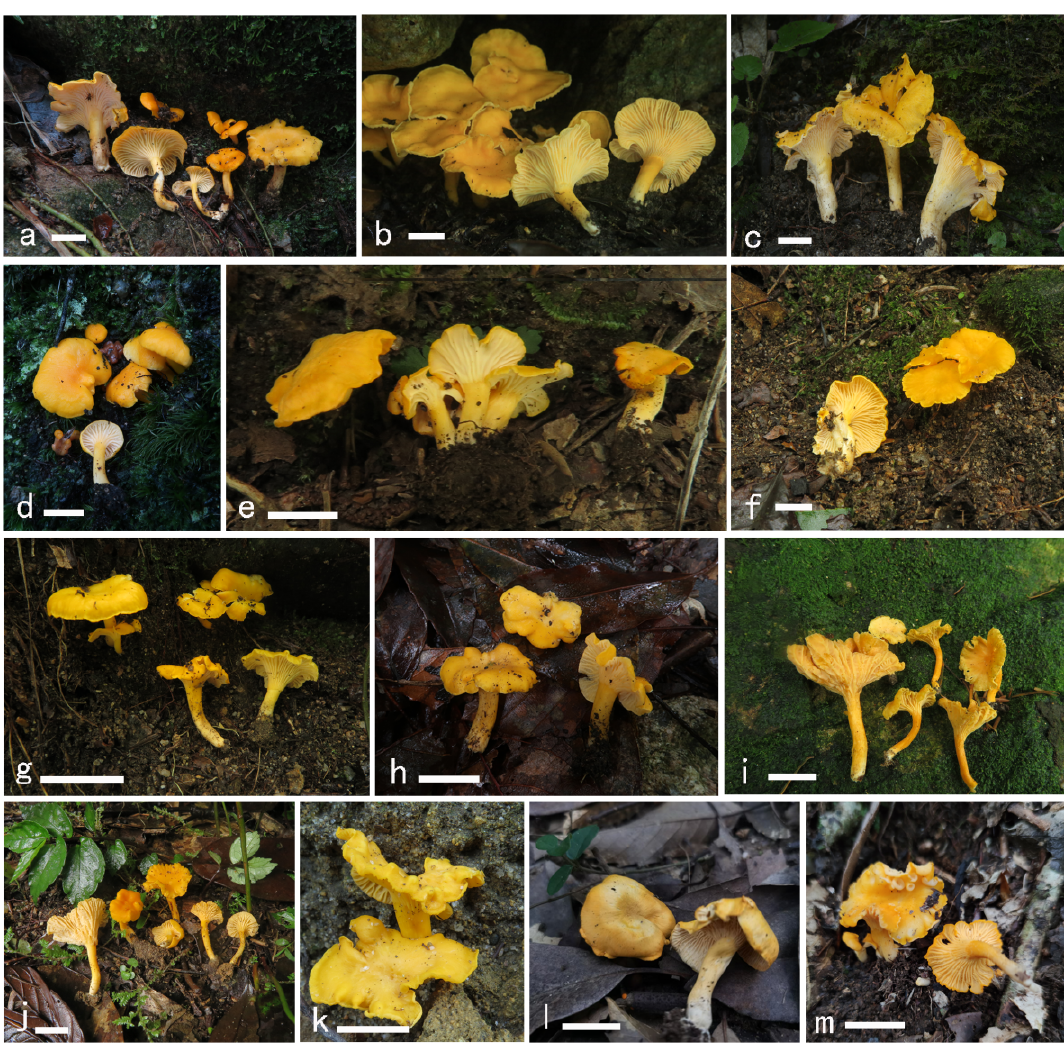
Figure 2. Basidiomata of Cantharellus chrysanthus. ( a , b ) GDGM80220, holotype. ( c ) GDGM60524. ( d ) GDGM80438. ( e ) GDGM82516. ( f ) GDGM80217. ( g ) GDGM49628. ( h ) GDGM80436. ( i ) GDGM60334. ( j ) GDGM80202. ( k ) GDGM45937. ( l ) GDGM85298. ( m ) GDGM82473. Bars = 2 cm. Basidiomata small-sized. Pileus 20–60 mm broad, convex, with involute margin when young, then gradually to nearly applanate or broadly infundibuliform with depressed center and inflexed to straight, irregularly undulate or slightly cracked at maturity; surface dry or hygrophanous, glabrous or finely subtomentose, orange (5A7–6A7) to deep orange (5A8–6A8) when young, slightly fading to orange yellow to yellow (3A7–4A7) when mature. Context yellowish white to orange white (4A2–6A2), 1–2 mm thick in the center of the pileus, sharply attenuate towards margin, unchanging when exposed. Hymenophore decurrent, subdistant, composed of bifurcate, 2–3 mm high venose folds, particularly towards pileus margin, pinkish white (7A2–10A2), but in some specimens yellowish white to orange white, unchanging when bruised. Stipe 20–60 × 3–14 mm, central, cylindrical or slightly tapering towards base, solid, glabrous or finely pubescent, concolorous with pileus or paler, unchanging when handled. Odor fruity and pleasant. Taste